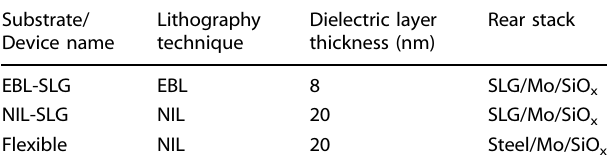
Table 2. Description of the samples ’ nomenclature, the thickness of the passivation layer, lithography used and the rear